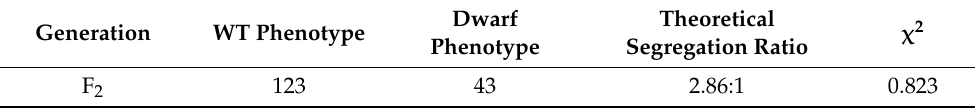
Table 2. The segregation ratio of F 2